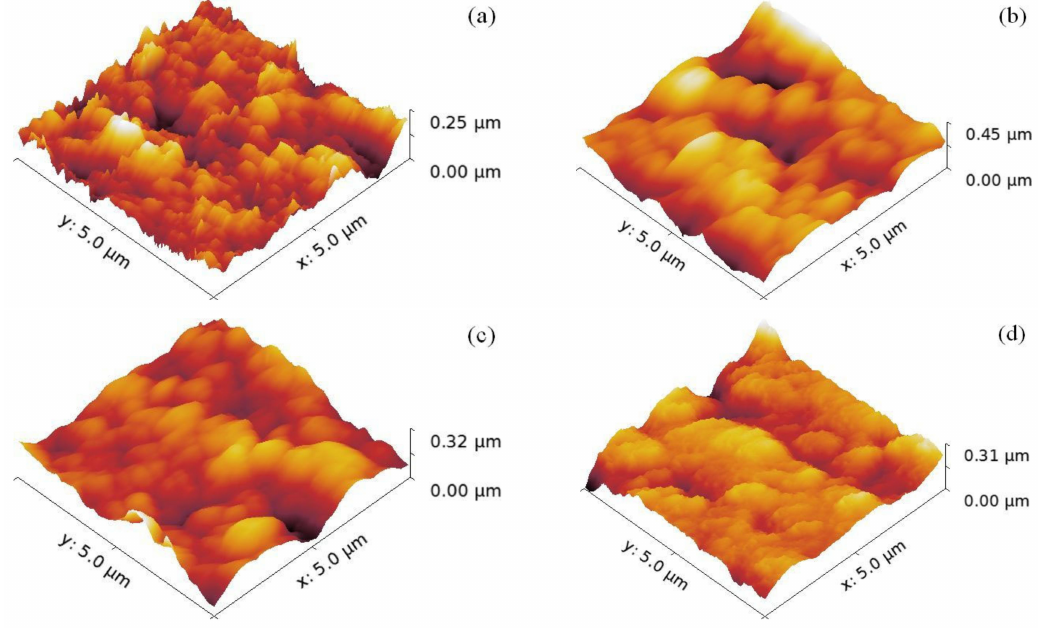
Figure 2. 3D AFM images of: ( a ) the reference sample, ( b ) TZN_30, ( c ) TZN_60, and ( d )